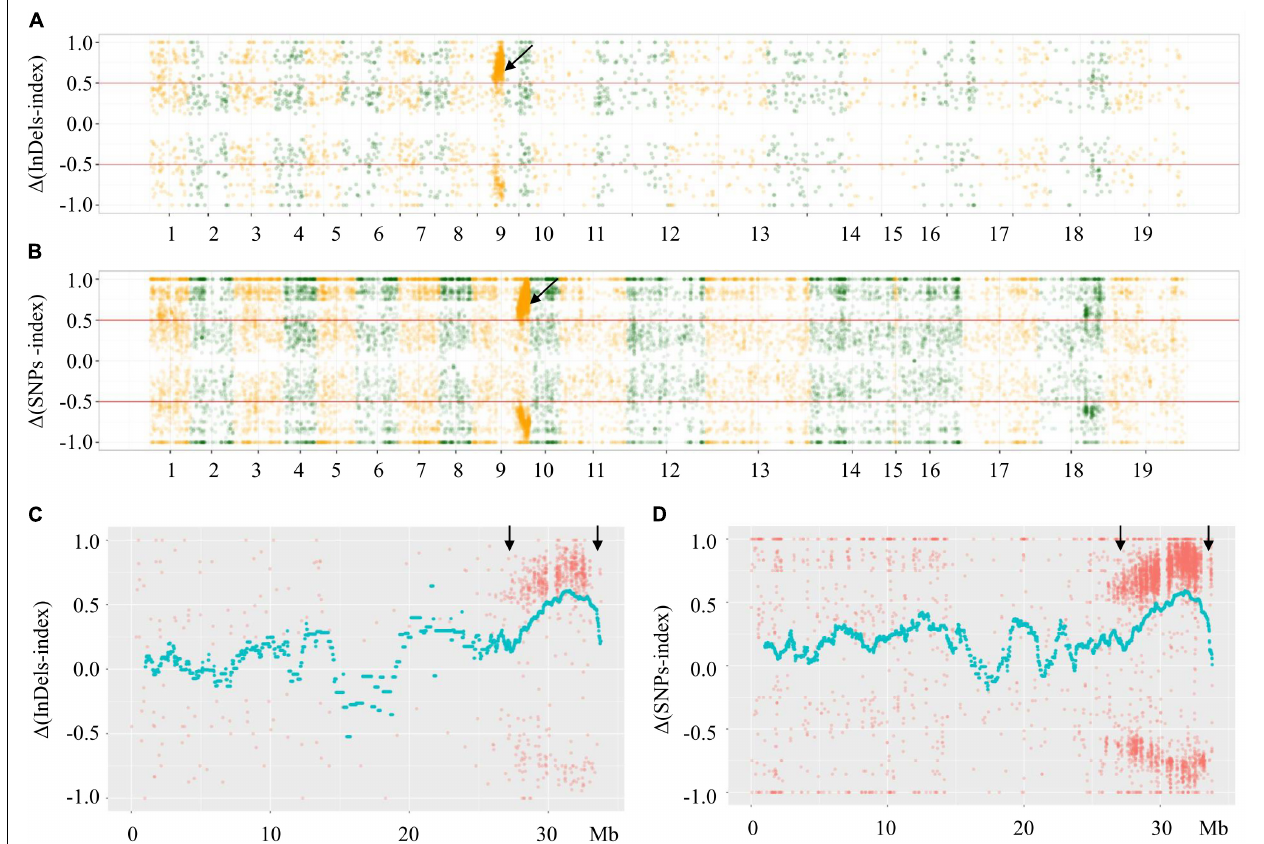
FIGURE 3 | Distributions of (cid:49) (SNPs/InDels-index) across B. napus chromosomes. (A) (cid:49) (InDels-index) plot obtained by subtraction of F-pool InDel-index from S-pool InDel-index for F 2 population; (B) (cid:49) (SNPs-index) plot obtained by subtraction of F-pool SNP-index from S-pool SNP-index for F 2 population; (C) (cid:49) (InDels-index) on chromosome A09; (D) (cid:49) (SNPs-index) on chromosome A09. The x -axes show the B. napus genome position. The y -axes show the index values; red lines in (A,B) represent index = | 0.5| . Each spot corresponds to an index value. The fitted curves indicate the average values of (cid:49) (SNPs-index) or (cid:49) (InDels-index) based on sliding window analysis. The black arrows indicate the candidate regions.